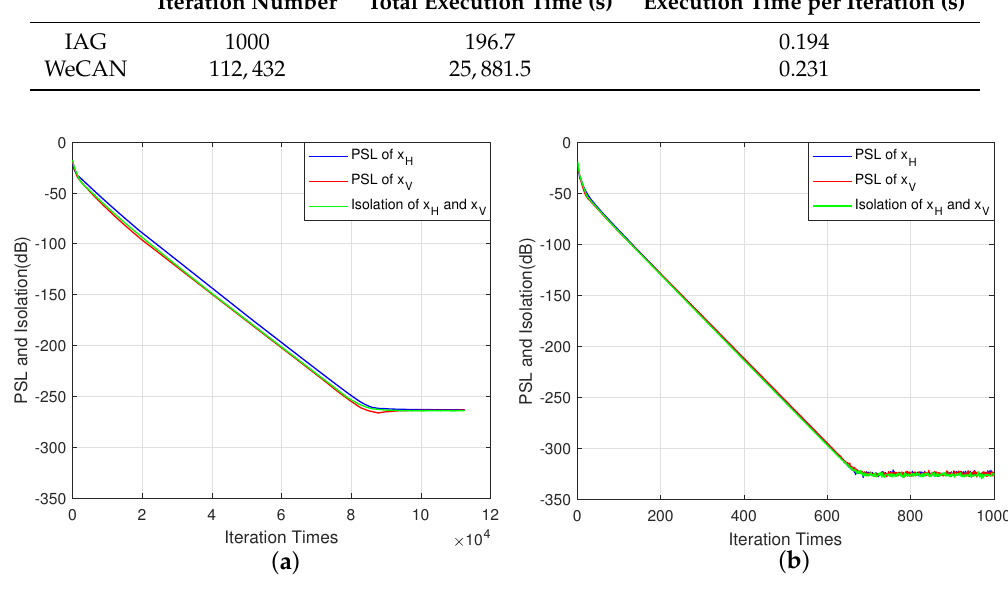
Figure 1. The convergence curves of the WeCAN approach and the IAG approach. ( a ) WeCAN; ( b ) IAG.